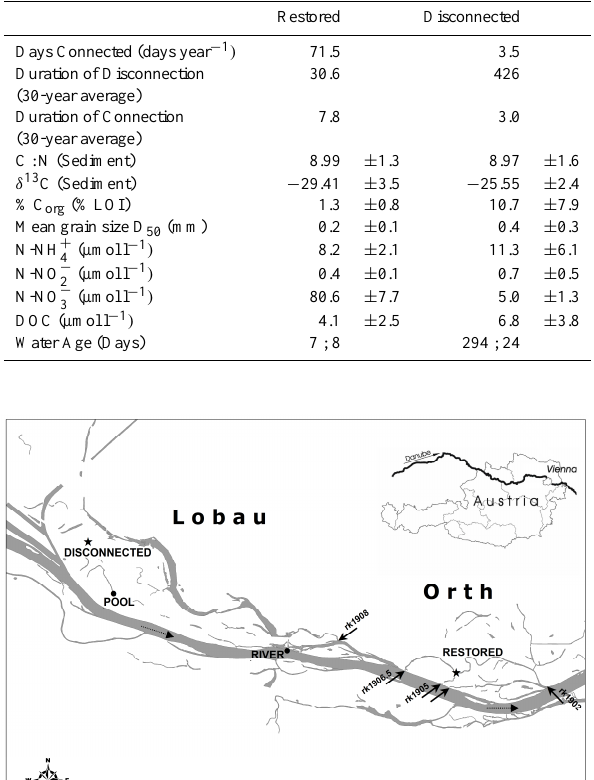
Table 1. Site description of hydrology, mean ( ± SD) sediment car- bon pools, and in situ water chemistry prior to mesocosm incuba- tions. The two water ages refer to the two separate sampling days.